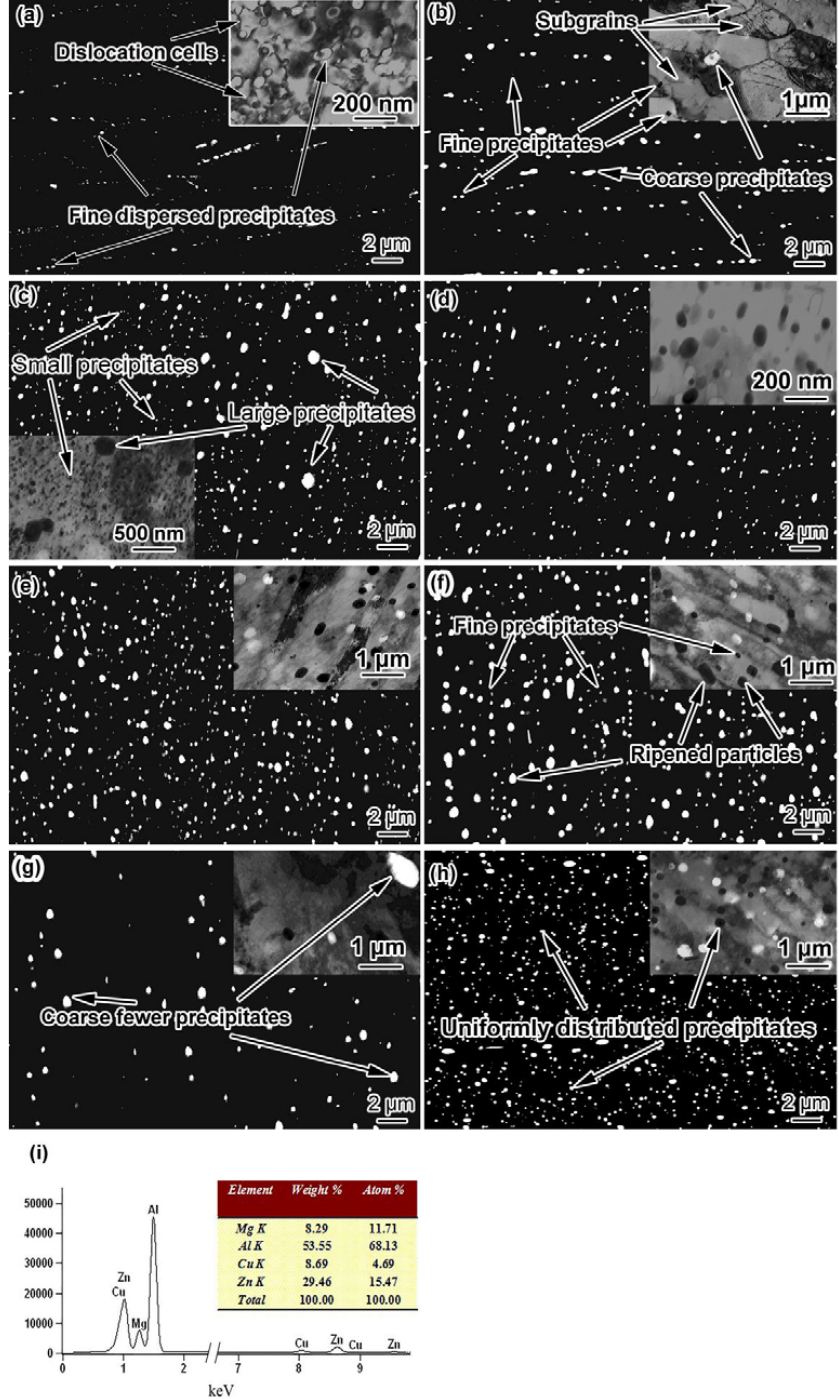
Figure 5. SEM microstructures (by backscattered electron) with embedded TEM microstructures: ( a ) DRTMT-60%; ( b ) DRTMT-IA; ( c ) DRTMT 1 ; ( d ) DRTMT 2 ; ( e ) DRTMT 3 ; ( f ) DRTMT 4 ; ( g ) DRTMT 5 ; ( h ) CRTMT-80% and ( i ) EDS result of the white precipitates; ( j ) XRD spectrum after the 1st-stage deformation.